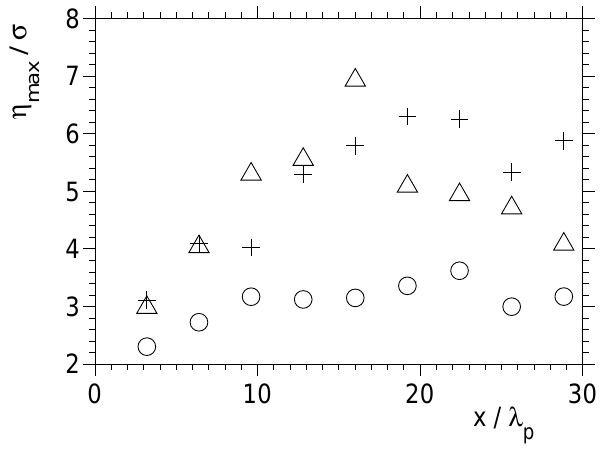
Fig. 5. Spatial evolution of the maximum surface elevation normalized by the standard deviation of the surface elevation: propagation without current ( ◦ ); propagation over a current with mean wave direction of 110deg (+); propagation over a current with mean wave direction of 120deg ( 4